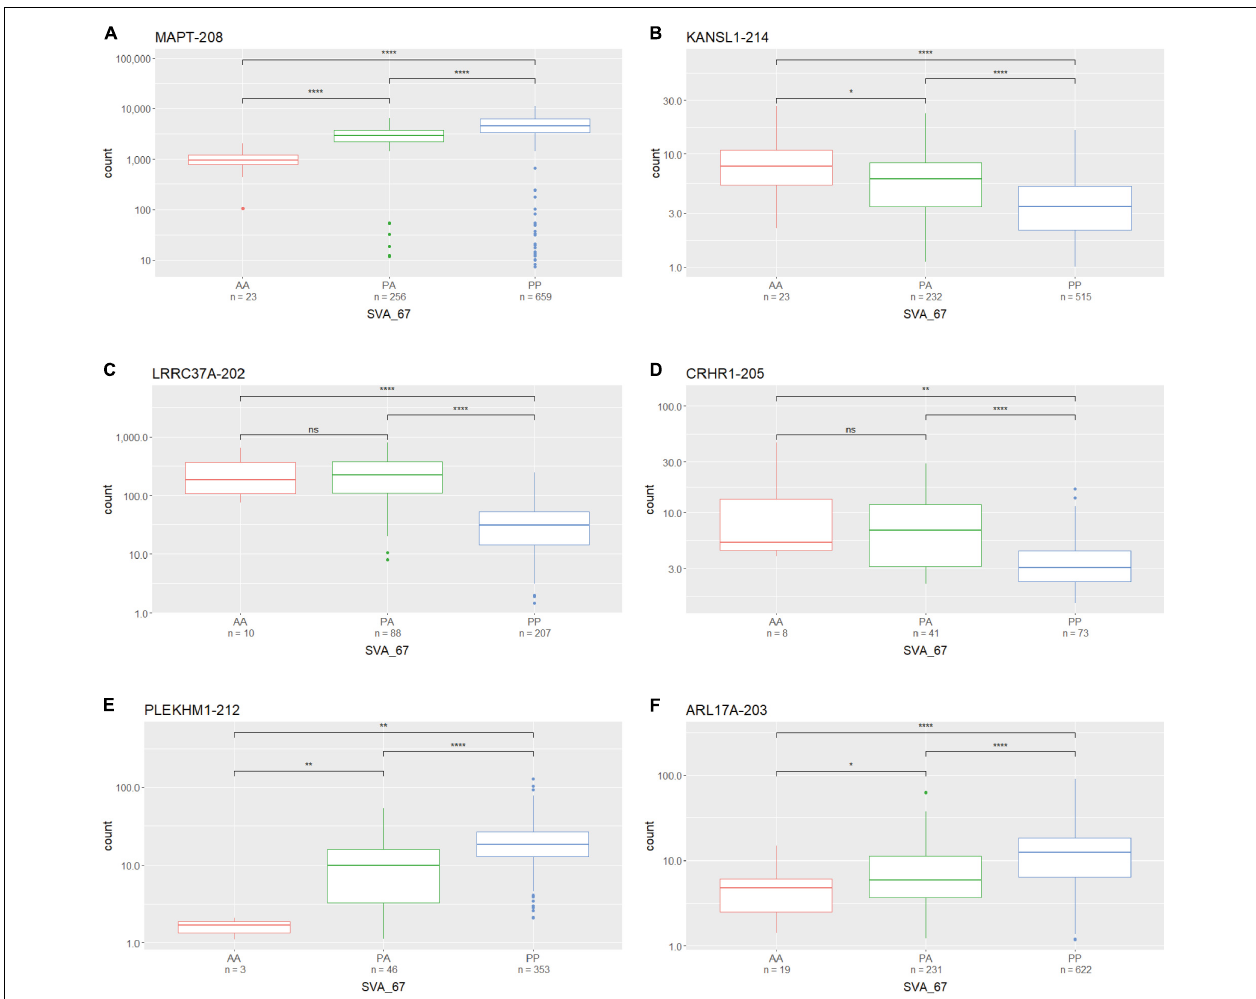
FIGURE 2 | The expression of several gene isoforms at the MAPT locus is associated with SVA_67 genotype. Association of SVA_67 genotype with expression of isoform MAPT-208 (A) , KANSL1-214 (B) , LRRC37A-202 (C) , CRHR1-205 (D) , PLEKHM1-212 (E) and ARL17A-203 (F) was analysed by the presence or absence of the SVA RIP (AA, PA, PP) using the NYGC ALS cohort. Wilcoxon test was applied to demonstrate statistical significance indicated as asterisks. * P ≤ 0.05, ** P ≤ 0.01, *** P ≤ 0.001, **** P ≤ 0.0001, ns > 0.05.